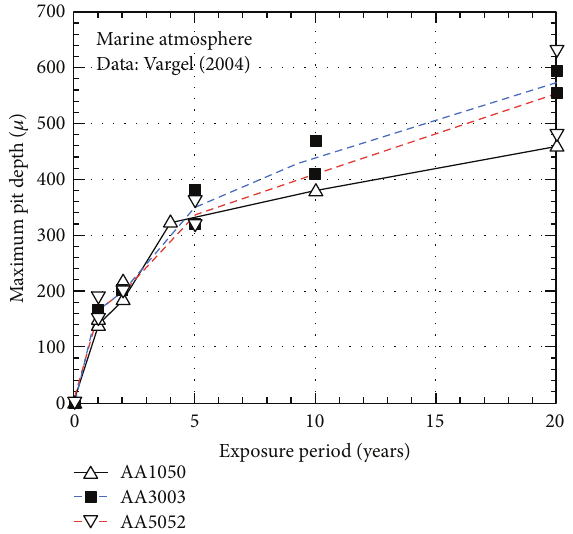
Figure6:DataformaximumpitdepthofaluminiumalloysAA1050, AA3003, and AA5052 exposed in unspecified marine atmospheres for up to 20 years. The trends for maximum pit depth are shown and are bimodal. The changeover to mode 2 occurs at about 2-year exposure. Data from Vargel [4].